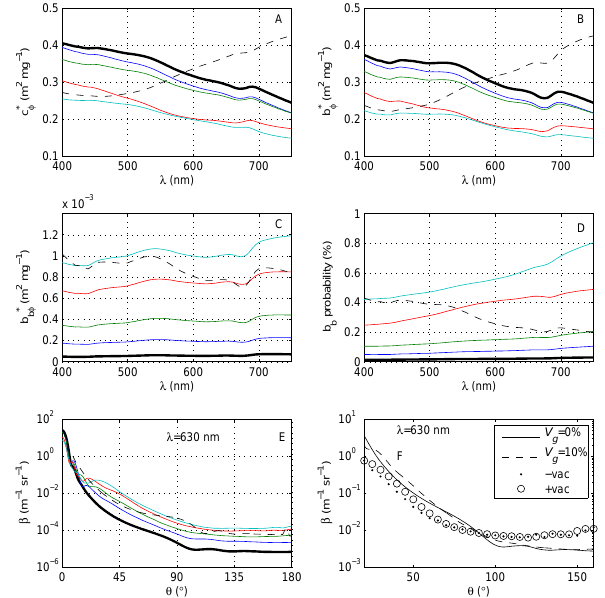
Fig. 6. Chl a -specific IOPs and VSFs for a population of M. aerugi- nosa modelled as two-layered spheres with variable gas vacuolation (0–50% cell volume) and 1 + (cid:15) =1.036. The dotted line in (A–E) is for a cell with V g =0% and 1 + (cid:15) =1.080. Legend same as Fig. 2. (F) shows comparison with measurements of Volten et al. (1998) (see Fig. 5 for details). (Fig. 6c, d). The heavily vacuolate cell ( V g = 50 %) scatters approximately the same as a non-vacuolate cell with the higher refractive index. The lower refractive index cell re- sponds in much the same way as the cell with the higher re- fractive index to vacuolation, with backscatter increasing in a roughly linear manner for increasing percentage